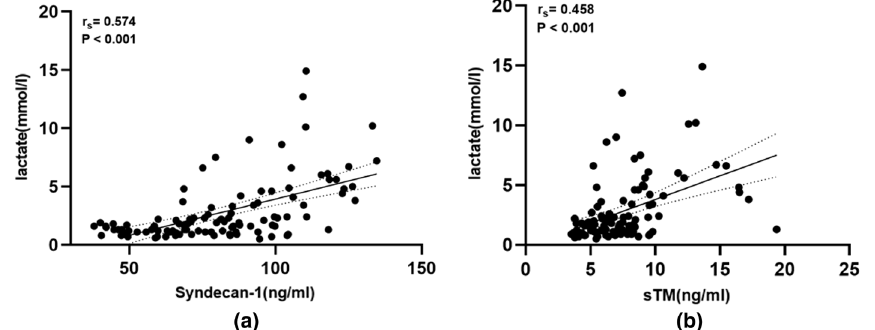
Figure 4. Serum syndecan-1 and sTM levels were associated with tissue perfusion. ( a ) Correlation between serum syndecan-1 and Lac in all the patients enrolled on ICU admission. ( b ) Correlation between serum sTM and Lac in all the patients enrolled on ICU admission. P < 0.05 were considered statistically significant. sTM serum thrombomodulin, ICU intensive care